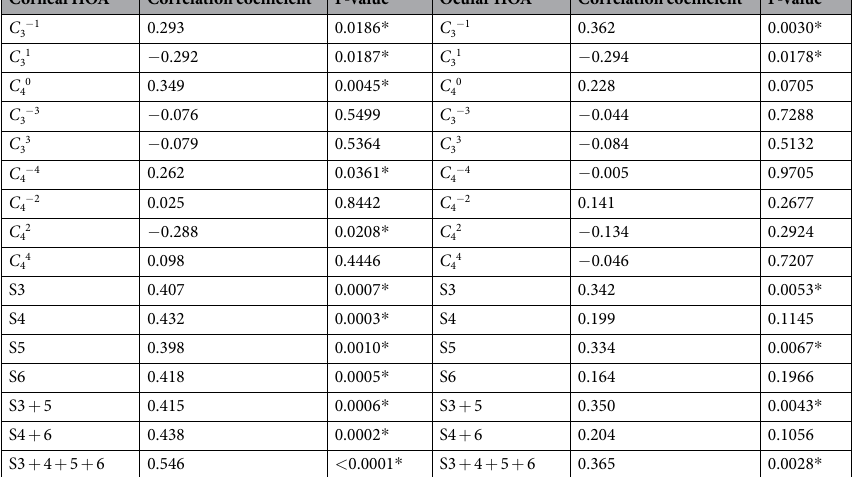
Table 2. Results of univariate analysis between averaged HOA components and myopia progression. HOA = higher-order aberration; C 3 − 1 = vertical coma aberration; C 3 1 = horizontal coma aberration;